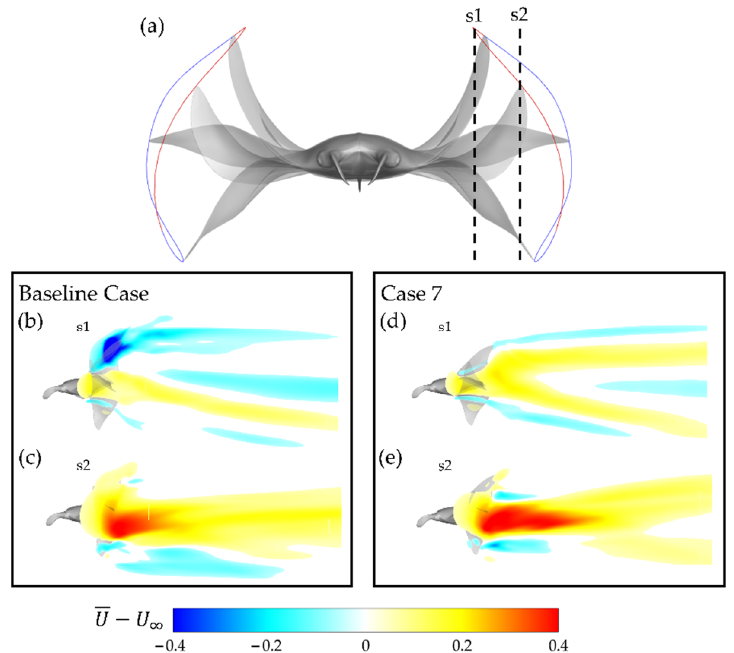
Figure 13. ( a ) Illustration of location of slice cuts relative to the manta body with downstroke motion (red trajectory) and upstroke motion (blue trajectory) visualized; ( b , c ) baseline case (BR = 1.0 PR = 1.0) and ( d , e ) case 7 (BR = 0.83 PR = 0.67 ) mean flow at slice